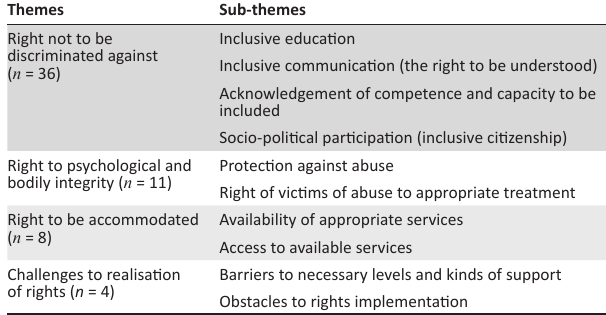
TABLE 5: Themes and